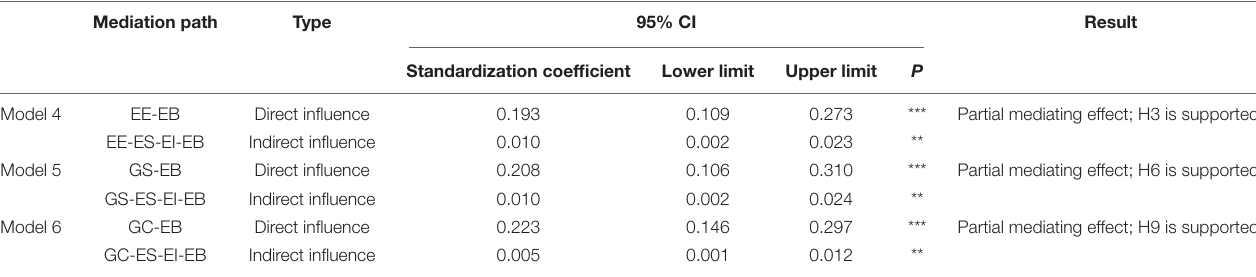
TABLE 5 | Influence test with entrepreneurial self-efficacy and entrepreneurial intention as serial double mediator. Mediation